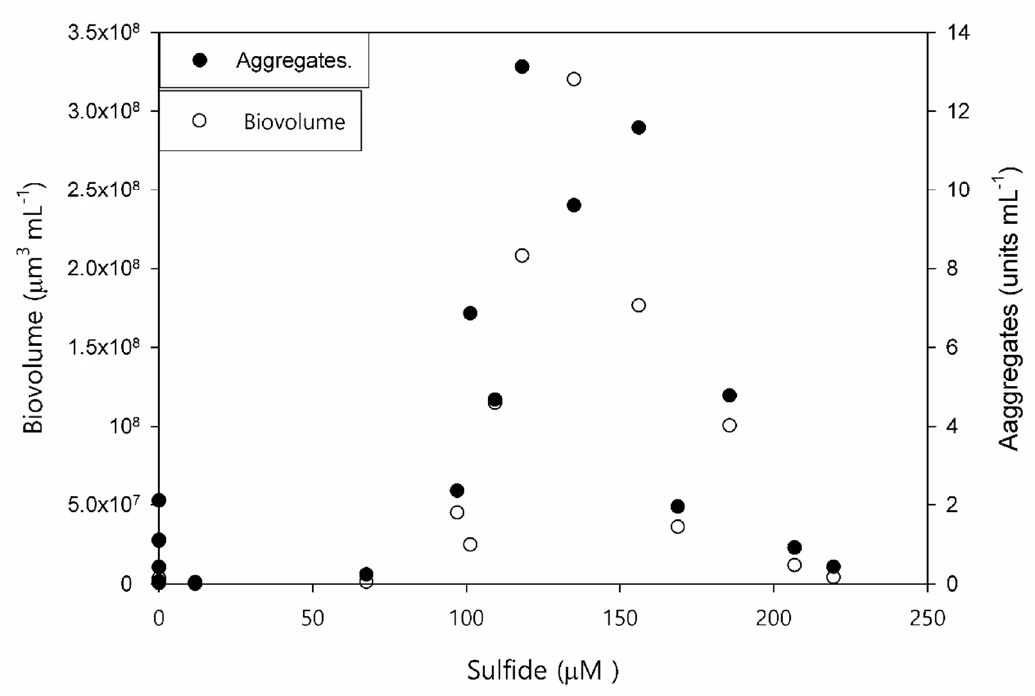
Figure 4. Biovolume (Biov.) and abundance (Abund.) of aggregates of Oscillatoria sp. versus sulfide concentration.